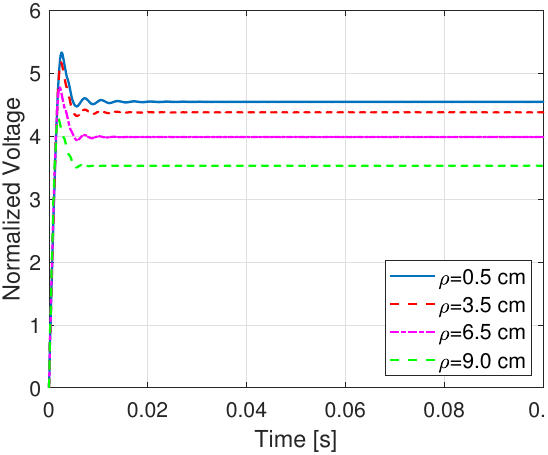
Figure 6. Load normalized voltages with h = 10 cm.